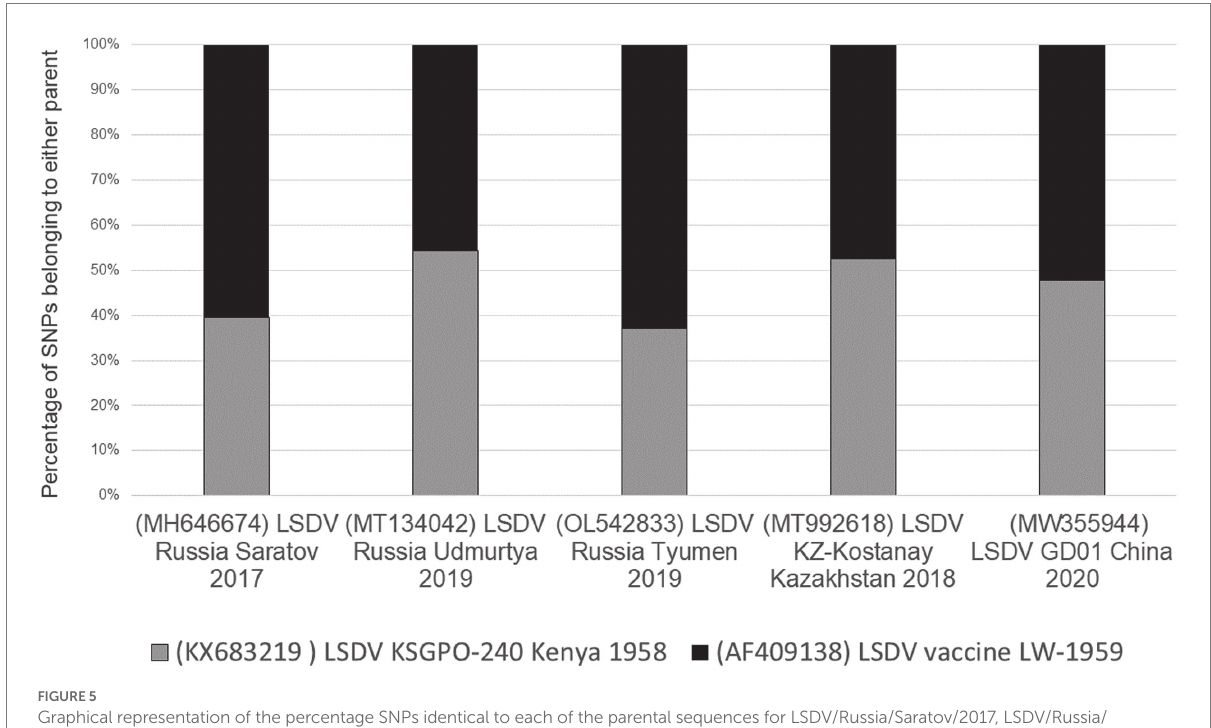
FIGURE 5 Graphical representation of the percentage SNPs identical to each of the parental sequences for LSDV/Russia/Saratov/2017, LSDV/Russia/ Udmurtya/2019, LSDV/Russia/Tyumen/2019, LSDV Kostanay/Kazakhstan/2018 and LSDV/GD01/China/2020 (Picture from Krotova et al., 2022a).